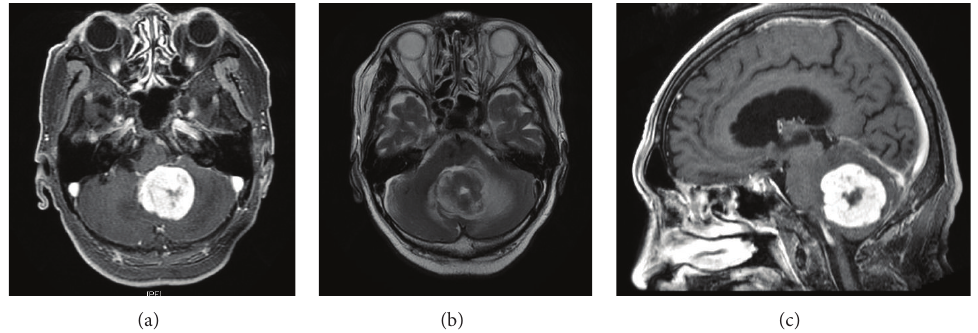
Figure 1: T1-weighted (a, b) and T2-weighted (c) magnetic resonance imaging (MRI) revealing the tumor in the vermis with homogeneous enhancement by gadolinium. Note that the tumor compressing medulla resulting in obstructive hydrocephalus (b).